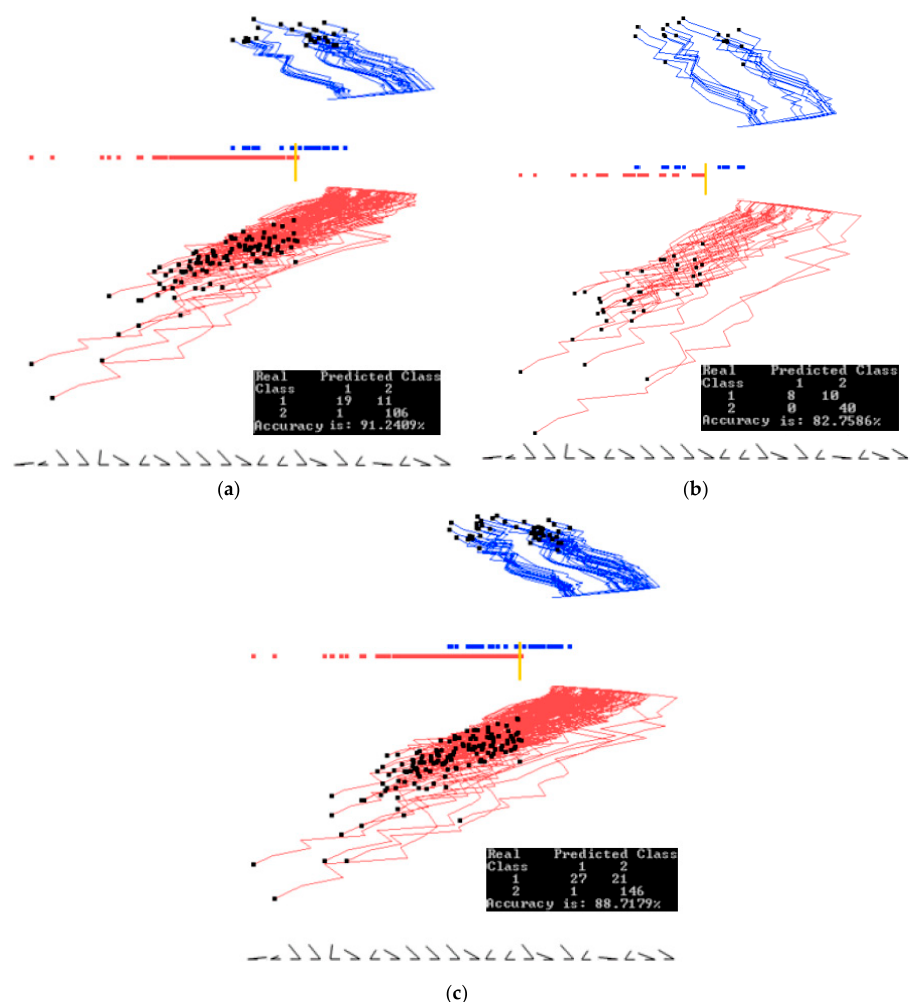
Figure 11. Results with Parkinson’s disease data set showing the training, validation and the entire data set when trained on the training set. ( a ) Data is split. Using 70% (training set) to find the coefficients. Projecting training set, best from the first runs of GLC-A; ( b ) Using coefficients found by the training set in (a) and projecting the validation dataset (30% of the data); ( c ) Projecting the entire data set using coefficients found by the training set in (a).